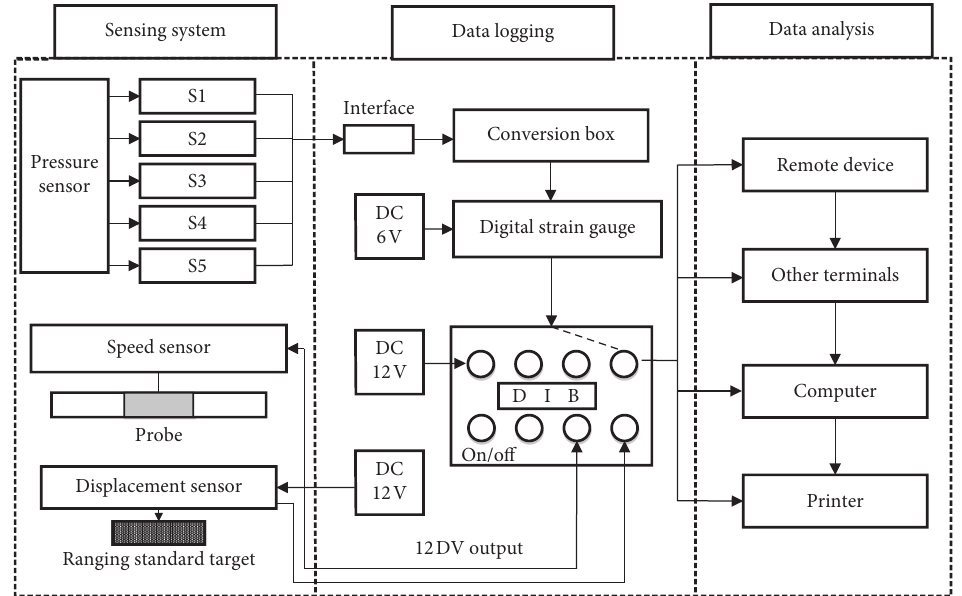
Figure 1: Structural design of geological identification while drilling